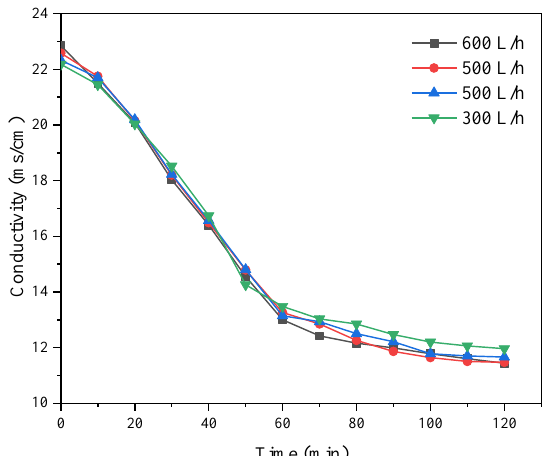
Figure 18. Diagram of conductivity changes with time of the fresh cell at different flow rates.